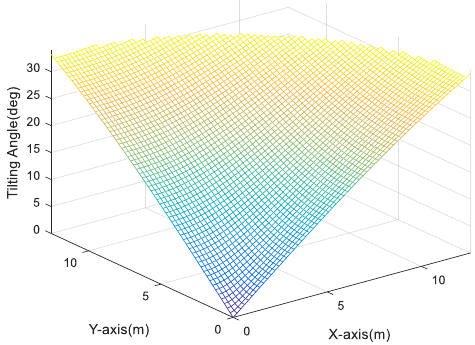
Figure 5. Optimal tilted angle distribution when the receiver is located on the X – Y plane.